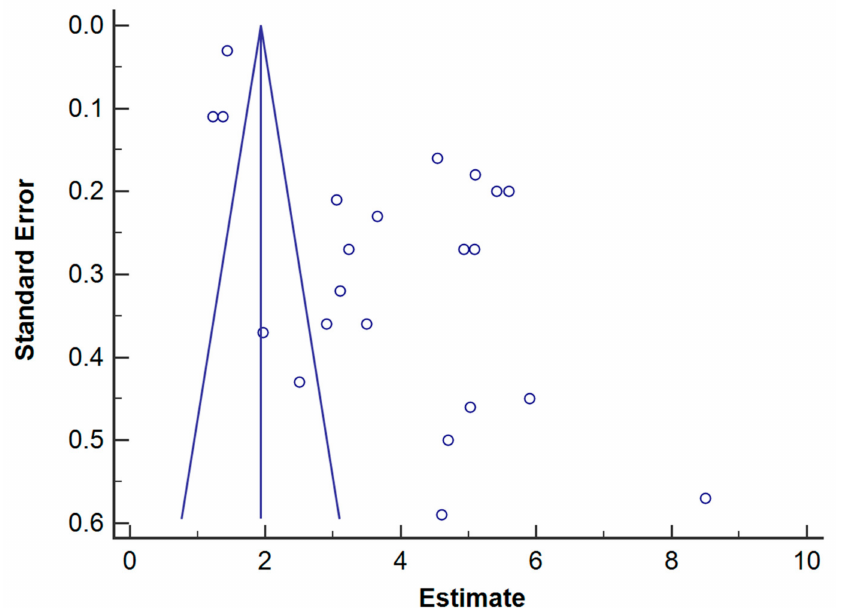
Figure 4. Horizontal bone gain funnel plot. Estimate of bone gain measurement is on the horizontal axis and study precision (standard error) appears on the vertical